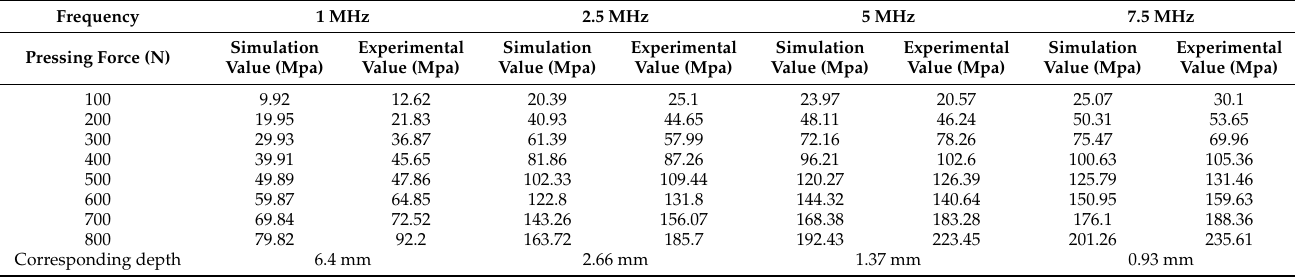
Table 3. Comparison between the theoretical value of loading stress and the test value.